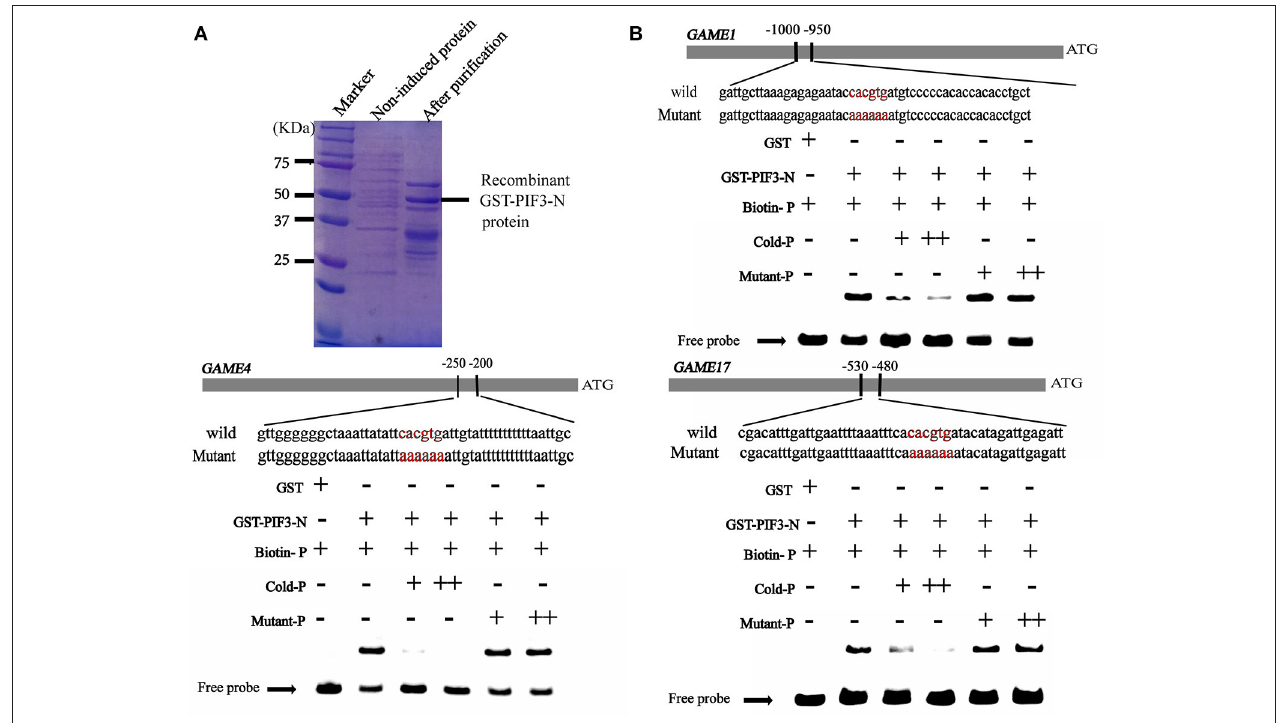
FIGURE 6 | Electrophoretic mobility shift assay (EMSA) showing the association of Sl PIF3 with promoters of SGA biosynthetic genes SlGAME1 , SlGAME4 , and SlGAME17 . (A) SDS–PAGE gel stained with Coomassie blue showing affinity purification of the recombinant Sl PIF3 protein used for the EMSA. (B) Sl PIF3 binds directly to the promoters of SlGAME1 , SlGAME4 , and SlGAME17 containing G-box (CACGTG) elements. Biotin-labeled DNA probe from the promoters or mutant probes were incubated with GST-PIF3 protein and the DNA-protein complexes were separated on 6% native polyacrylamide gels. + or ++ indicate increasing amounts of unlabeled probes as the